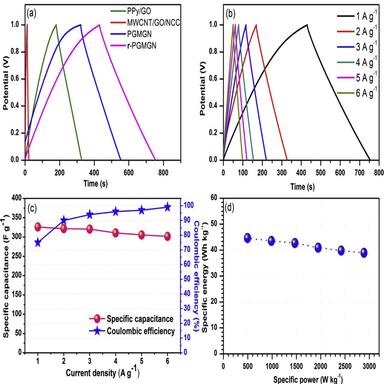
(A) GCD curves of symmetrical supercapacitor devices for PPy/GO, PPy/rGO, MWCNT/GO/NCC, MWCNT/rGO/NCC, PGMGN and r-PGMGN at a current density of 1 A g−1 , (b) GCD curves, (c) specific capacitances and coulombic efficiency and (d) Ragone plot of r-PGMGN based symmetrical supercapacitor device at current densities between 1 and 6 A g−1 .